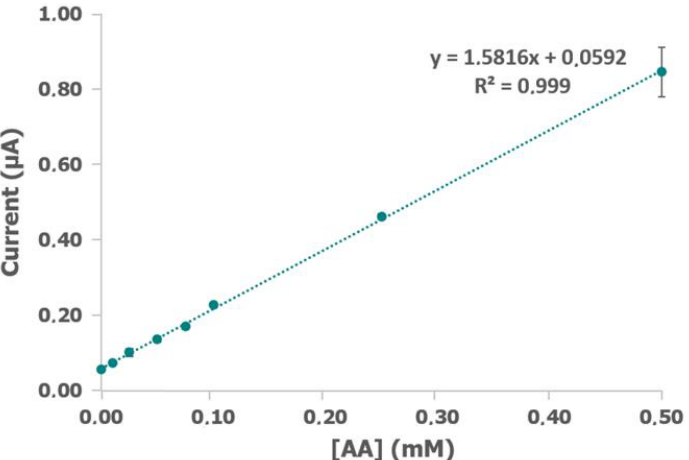
Figure 2. Calibration plot of current obtained after applying +0.40 V for 60 s with different concentra- tions of acetaldehyde (AA) and 0.07 U/mL ALDH, 0.07 U/mL DP, 1 mM NAD + , 1 mM K 3 [Fe(CN) 6 ], and 0.1% bovine serum albumin (BSA) in 0.1 M phosphate and 0.1 M KCl buffer solution (pH 8).